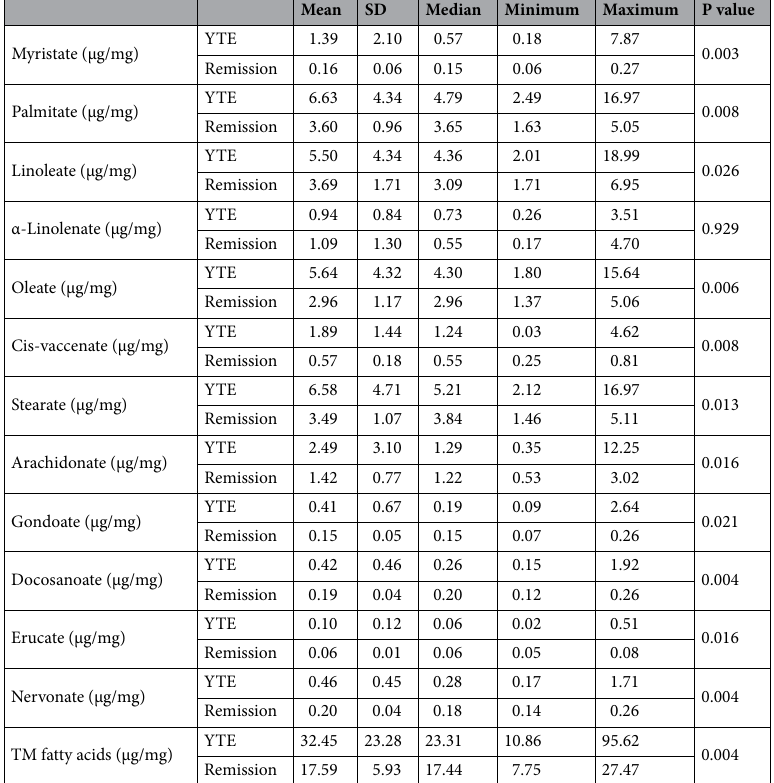
Table 8. Summary statistics of fecal fatty acid concentrations in YTE dogs before and after treatment. TM, total measured; YTE, Yorkshire Terrier enteropathy; SD, standard